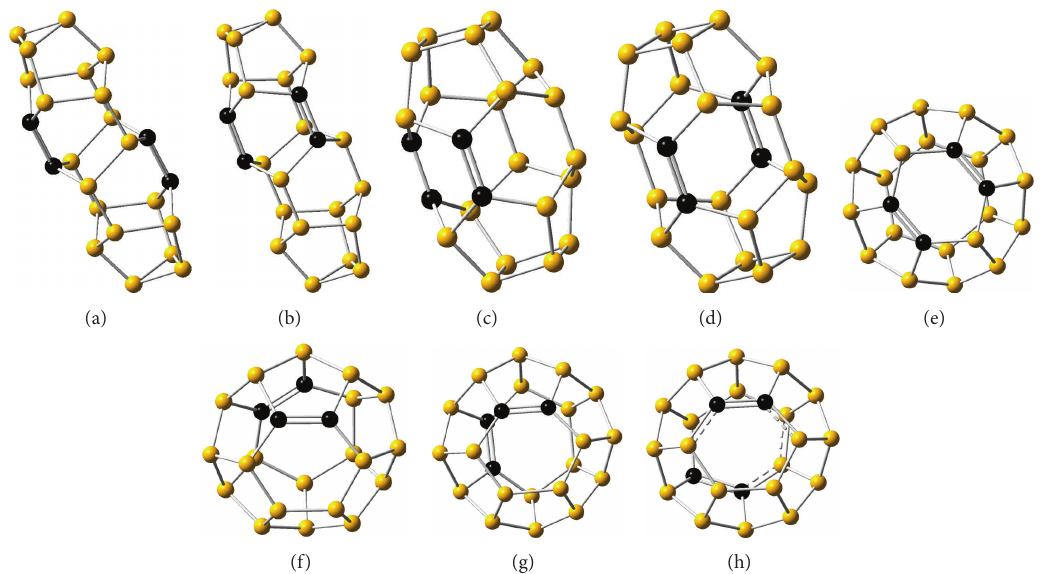
Figure 2: Isomers of N 20 C 4 : (a) isomer T1, (b) isomer T2, (c) isomer S1, (d) isomer S2, (e) isomer H1, (f) isomer H2, (g) isomer H3, and (h) isomer H4. Carbon atoms are shown in black, and nitrogen atoms are shown in